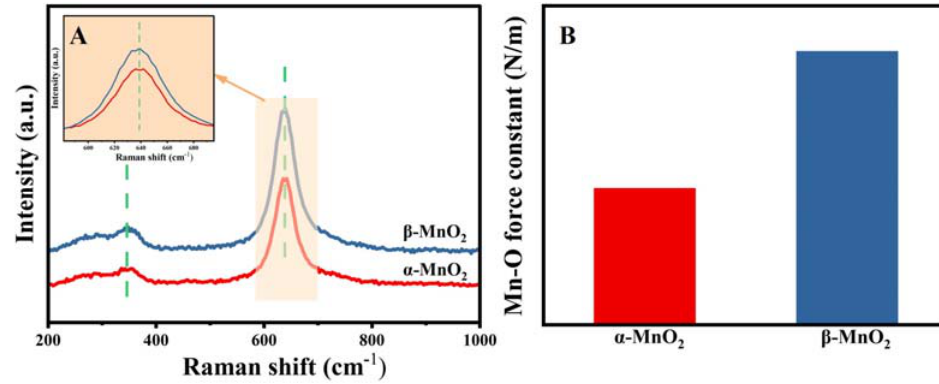
Figure 8. Raman profiles ( A ) and the Mn-O force constant ( B ) of α -MnO 2 and β -MnO 2 .